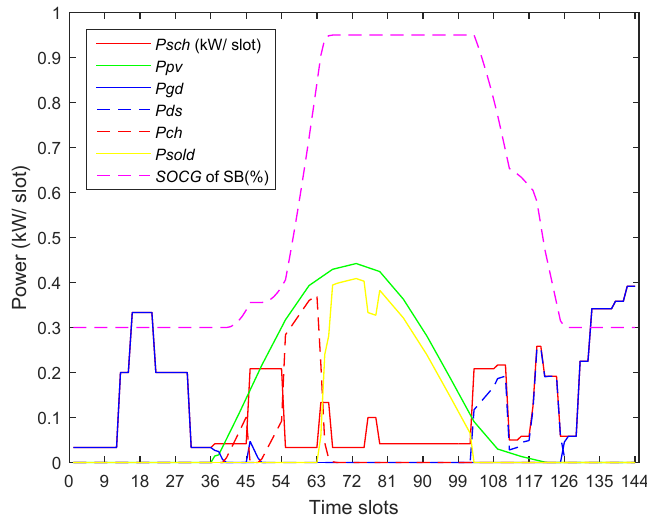
Figure 31. Load profile for maximal reduction in CE using DA-RTP (DS) for PDDR-RED-based HEMS.